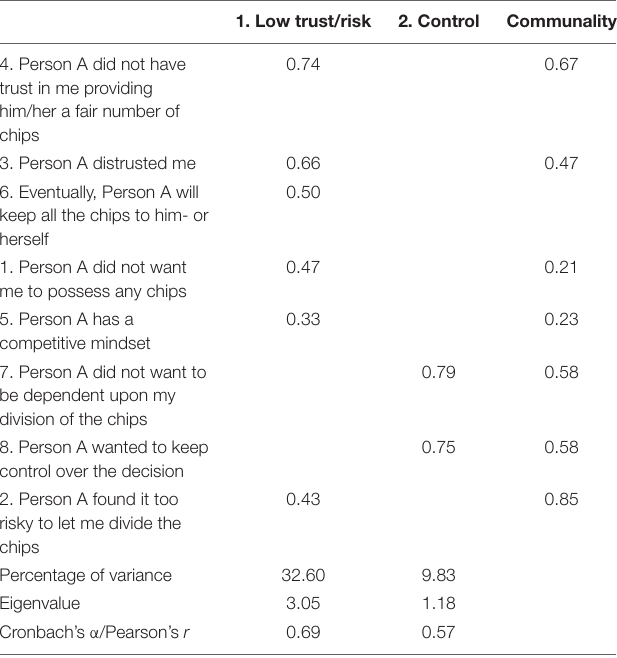
TABLE 3 | Factor loadings based on an exploratory factor analysis with a principal axis factoring and direct oblimin rotation on eight items measuring the perceived underlying motives ( N = 124).